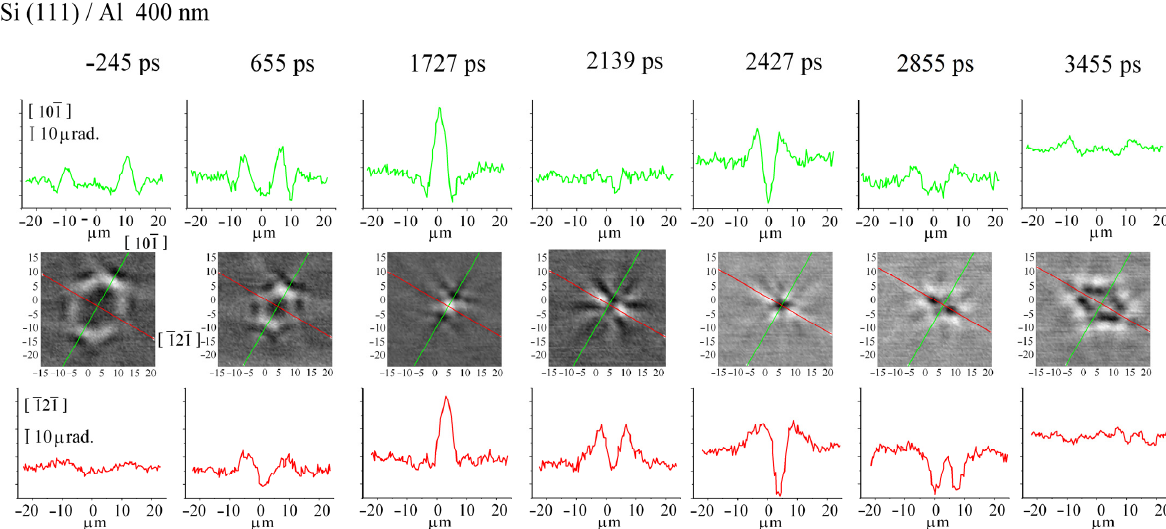
Figure 6. Center block of pictures: converging SAW field on silicon with orientation (111) covered by aluminium film at several time moments. Green lines indicate lateral direction (cid:4670)101(cid:4671) , red lines indicate lateral direction (cid:4670)121(cid:4671) . Top block and bottom block of pictures show SAW profile along these lines, respectively.